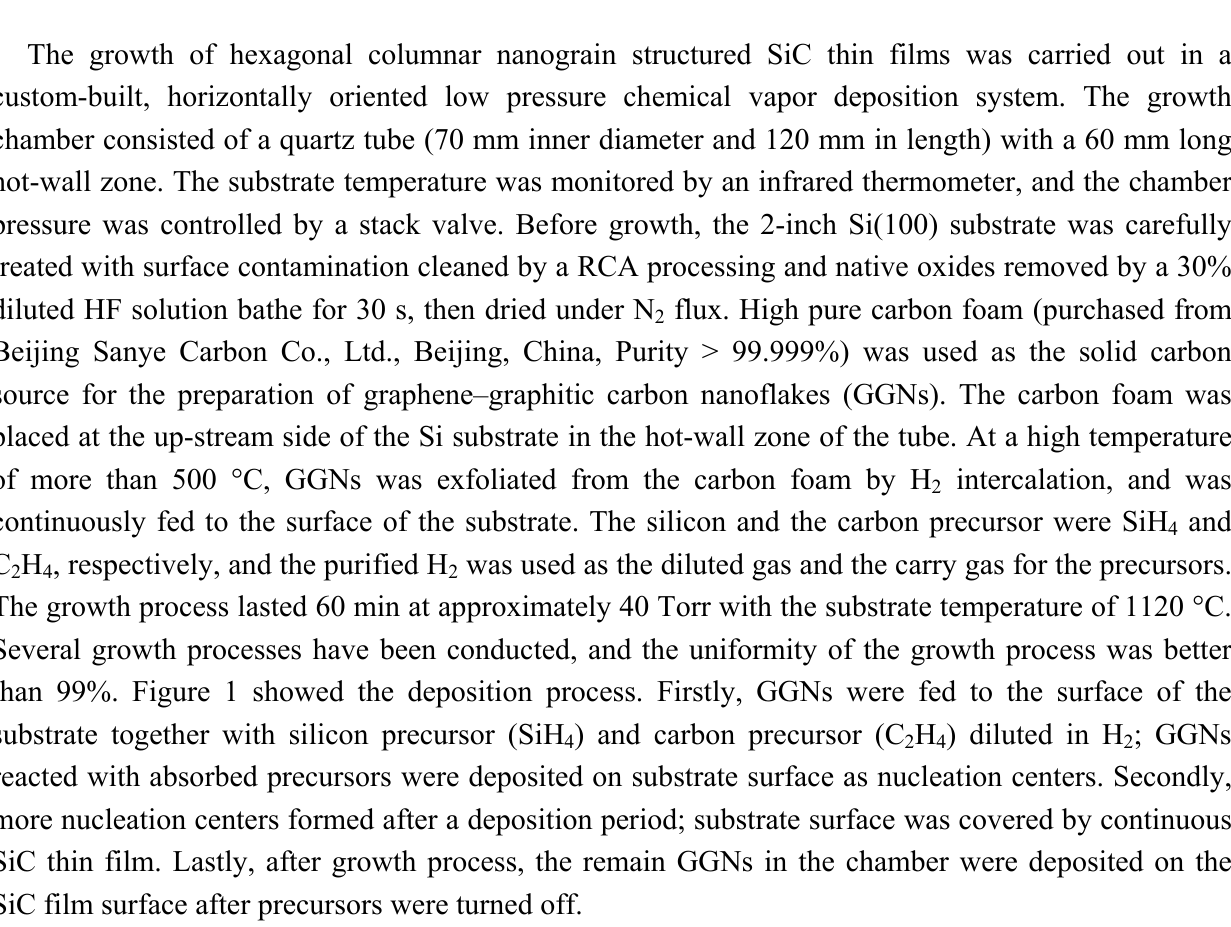
Figure 1. Deposition process